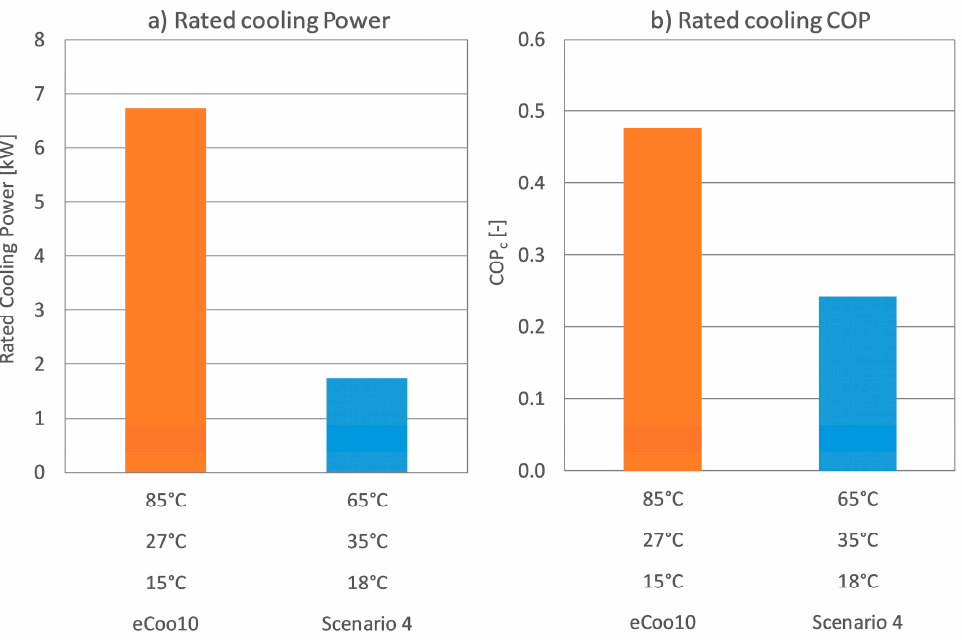
Figure 11. Experimental results of the eCoo10 for the heating application scenarios (1–3), ( a ) Rated heating power and ( b ) the rated COP for